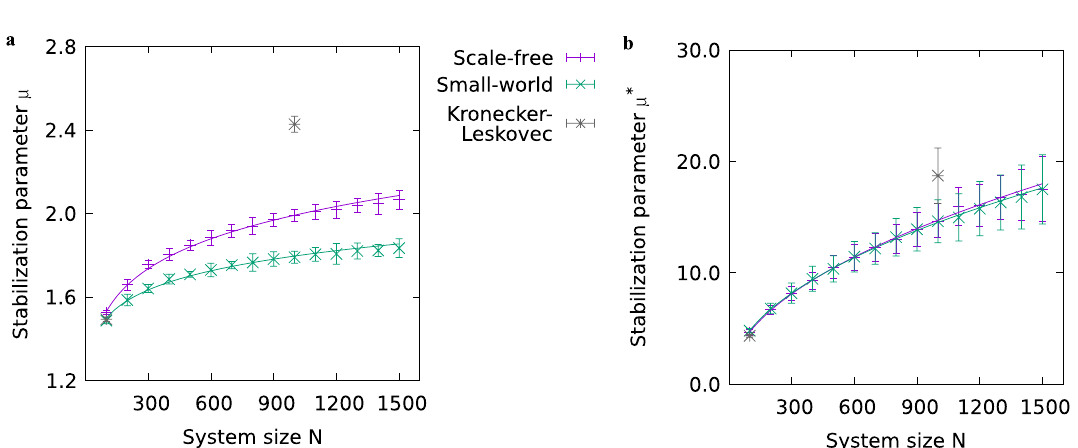
Figure 4. Stabilizing networks of different size and topology via self-coupling. The stabilization parameter (computed from fits to data points obtained from 1000 trials, cf. Eq. (2) and Fig. 2) is shown in relation to the 2, m 0 0 ) networks. Results 4, p rew 5% ) and scale-free ( m network size for both small-world ( k nn = = = = from Kronecker–Leskovec networks are shown for comparison. ( a ) Stabilization parameter µ , referring to the mean self-coupling strength. Self-coupling strengths were drawn from small intervals of fixed size and varied position. ( b ) Stabilization parameter µ ∗ , referring to the lower bound of the self-coupling strength. Self-coupling strengths were drawn from large intervals with fixed upper bound and varied lower bound. The error bars show the error propagated from the fit parameters from which the stabilization parameter is computed. Different power-law functions fit the behavior of the stabilization parameters. See Table 2 for the fit parameters and their